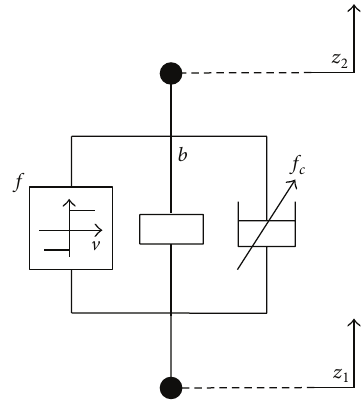
Figure 2: Dynamic model of fluid inerter.